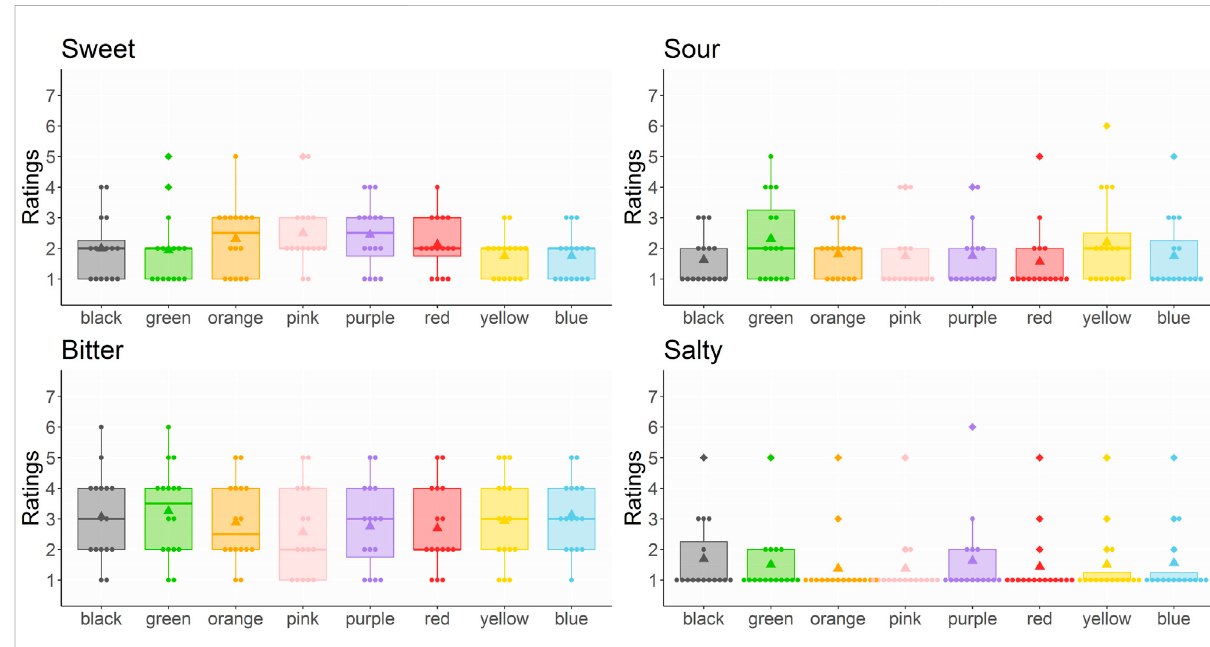
FIGURE 7 The descriptive statistics and the distribution of the results of taste rating ( Q2-1 ). The dots, triangles, lines and diamonds represent participants ’ ratings, average ratings, median and outliers,